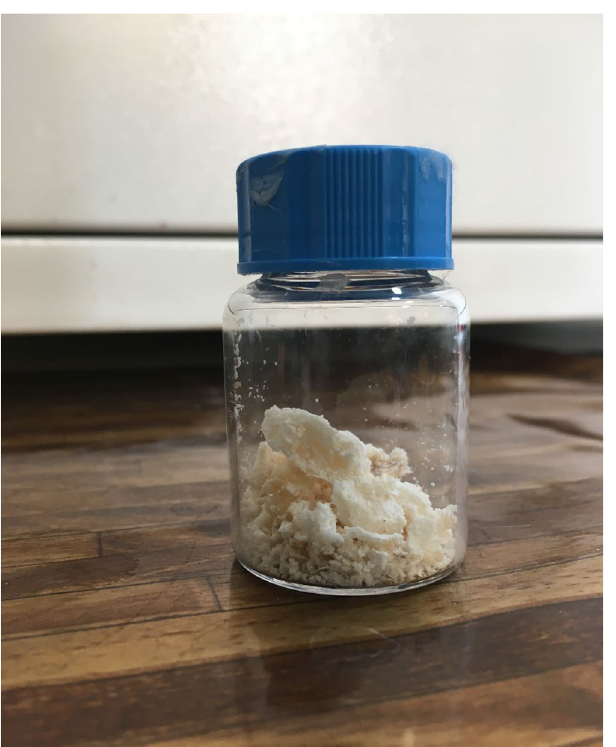
Figure 4. Difunctionalized PNIPAAM produced in SC-CO 2